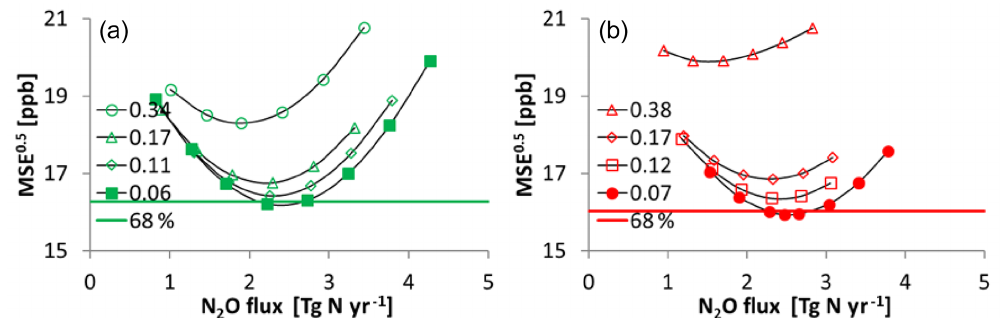
Figure 10. MSE 0 . 5 for the two N 2 O submodels compared to the (cid:49)p N 2 O database as a function of global N 2 O flux at different (net) N 2 O production rates in the low-O 2 regions. MSE min and confidence intervals as in Fig. 9. (a) Diagnostic submodel. The four lines represent the four best low O 2 production rates from Fig. 9a; each point represents a simulation, different symbols indicate different low O 2 ratios, and points with the same symbols have different oxic N 2 O production ratios. (b) Prognostic submodel. The four lines represent the optimised net production rates at the four best gross production rates from Fig. 9b; points with the same symbols have different N 2 O ratios for